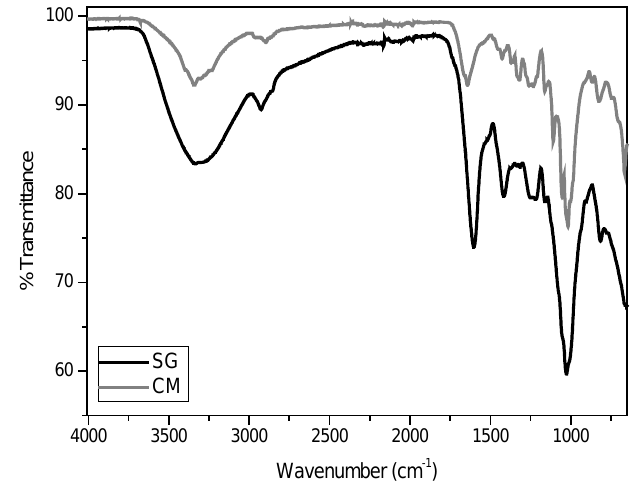
Figure 1. Fourier transformed infrared spectra spectra of Sargassum sp. (SG) and Chaetomorpha (CM) samples before phenol adsorption.